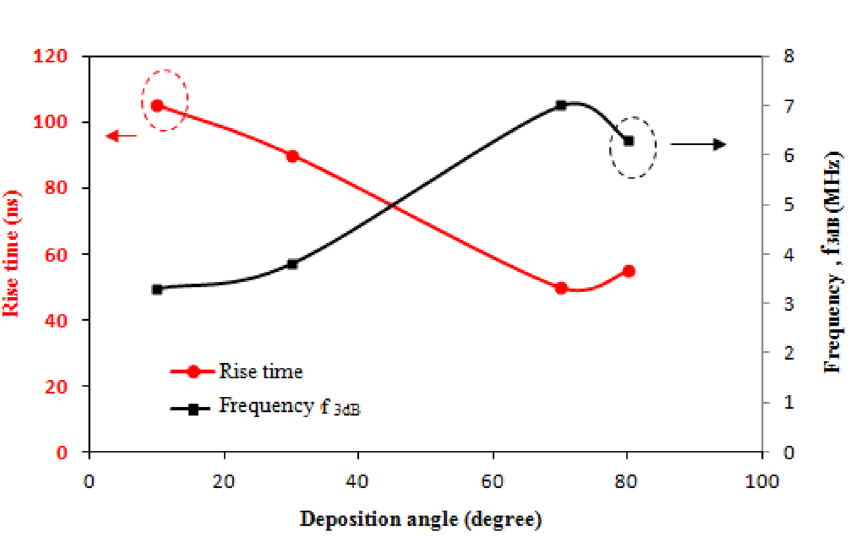
Figure 15. Variation of rise time and frequency bandwidth of the Sb detector with deposition angle for CO 2 laser pulse without using external